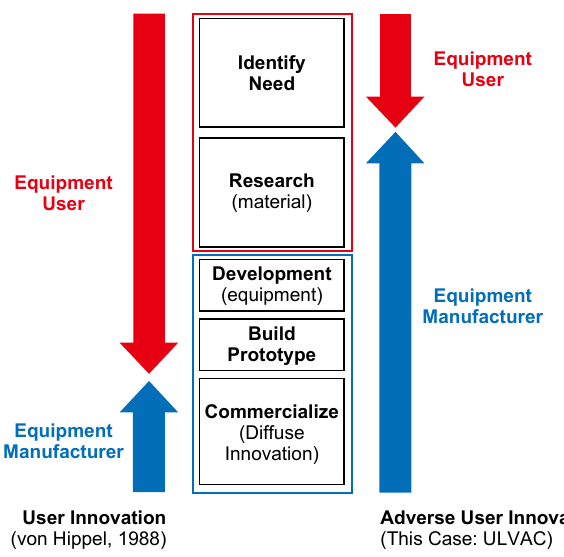
Figure 1. User innovation vs. adverse user